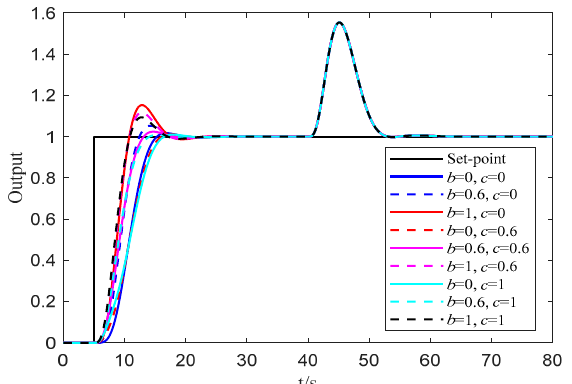
Figure A1. The response of